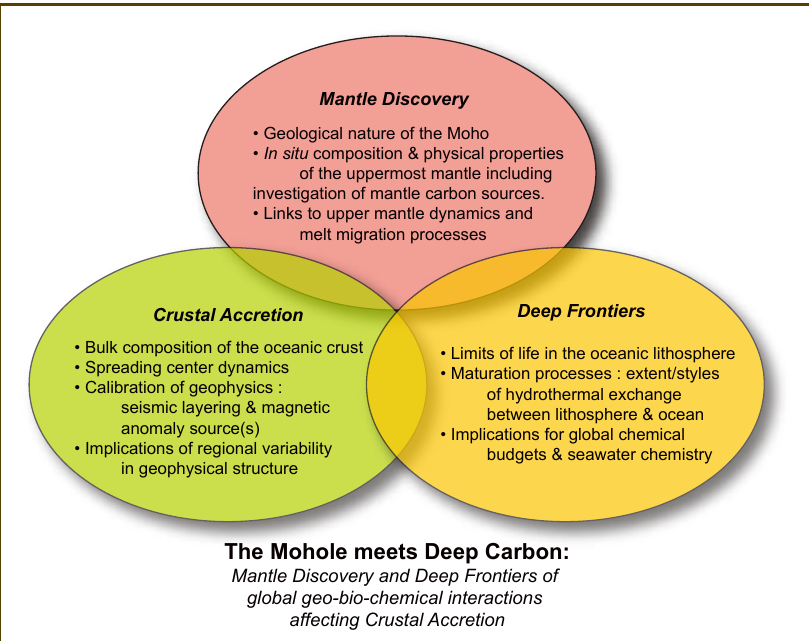
Figure 1. Scientific rationale discussed at the Workshop. After Ildefonse et al.